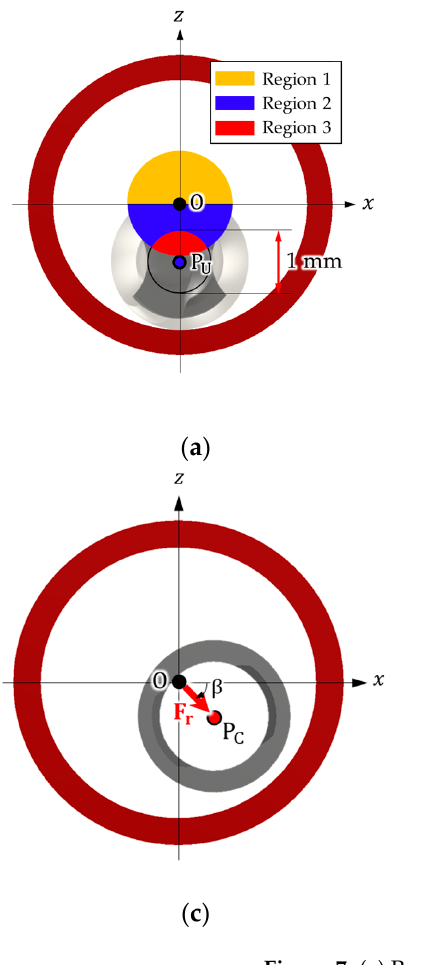
determined by OP (cid:2887) (cid:4652)(cid:4652)(cid:4652)(cid:4652)(cid:4652)(cid:4652)(cid:4652)⃗ cosγ (cid:3404) OP′ (cid:2905) (cid:4652)(cid:4652)(cid:4652)(cid:4652)(cid:4652)(cid:4652)(cid:4652)(cid:4652)(cid:4652)⃗ cosβ . After applying magnetic force in order to move the UMR to P U’ and terminating the magnetic force, the UMR moves in the − Z direction through a point coincident with P C due to gravity. Figure 7c represents the direction of F r when the center of the connecting part of the delivery catheter is in region 2 and the Z- coordinate of P C is negative. In region 3, as shown in Figure 7d, F r is not applied because